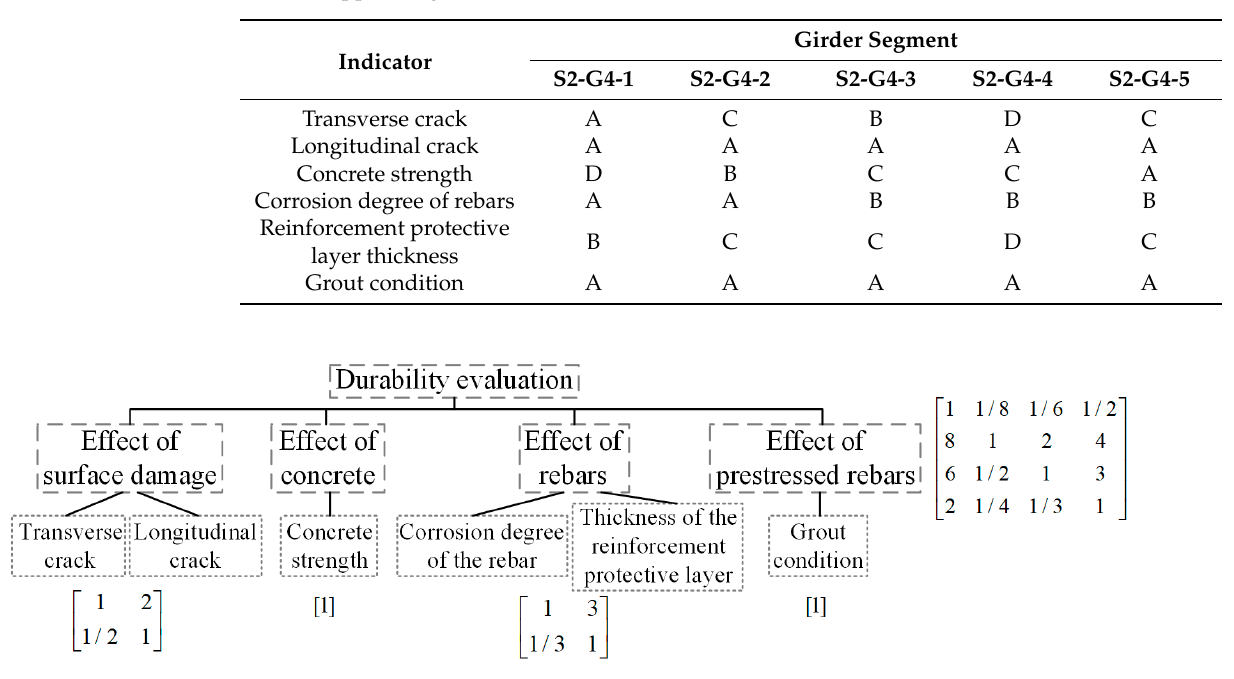
Table 8. Appraisal grade of the indicators in S2-G4.